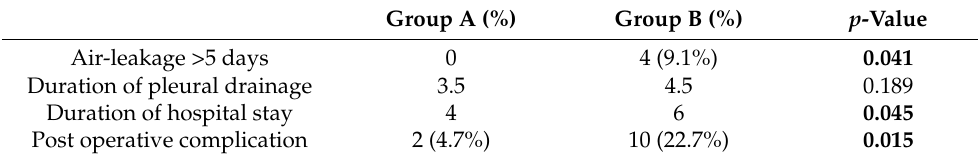
Table 2. Primary and secondary end